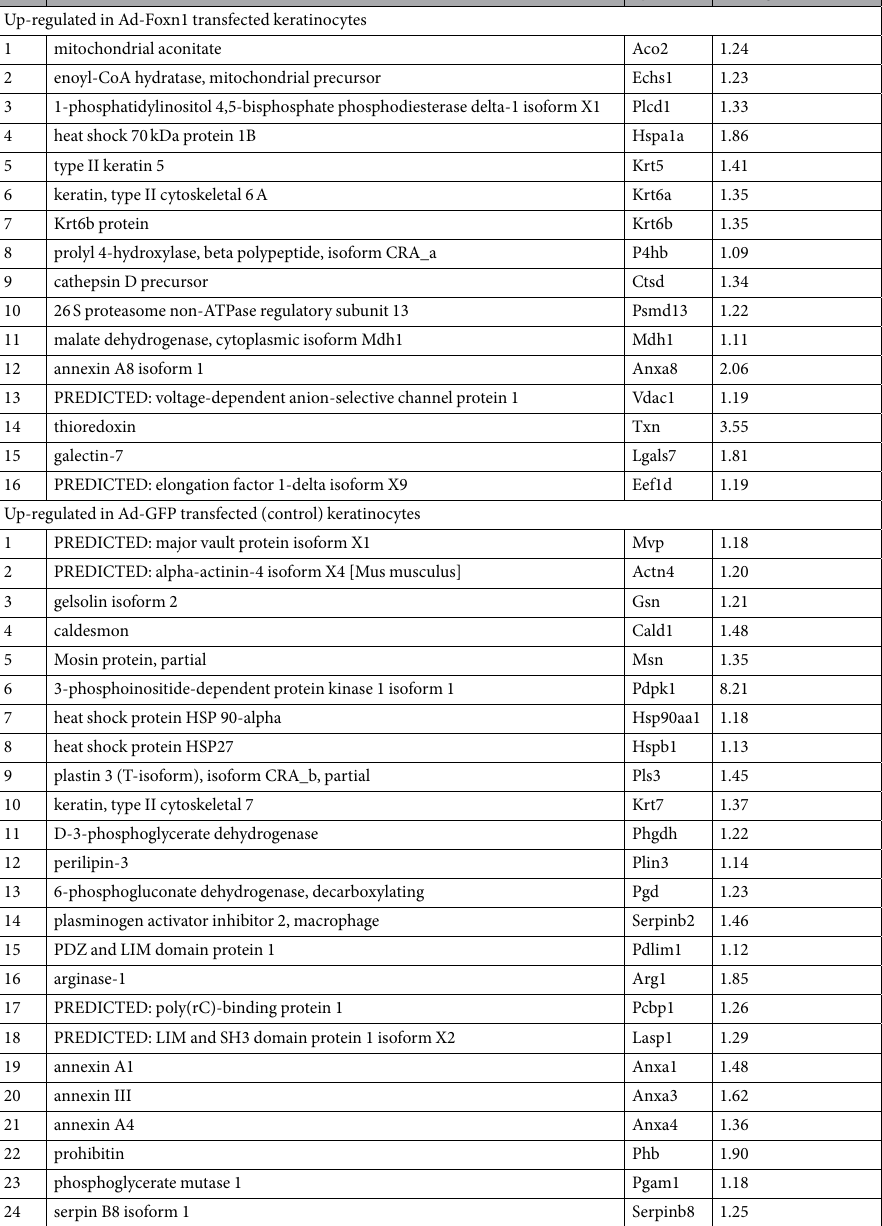
Table 1. Simplified list of proteins with differential abundance in keratinocytes transfected with Ad-Foxn1 and control keratinocytes (transfected with Ad-GFP). * For a full list of results obtained for particular isoforms, see Table